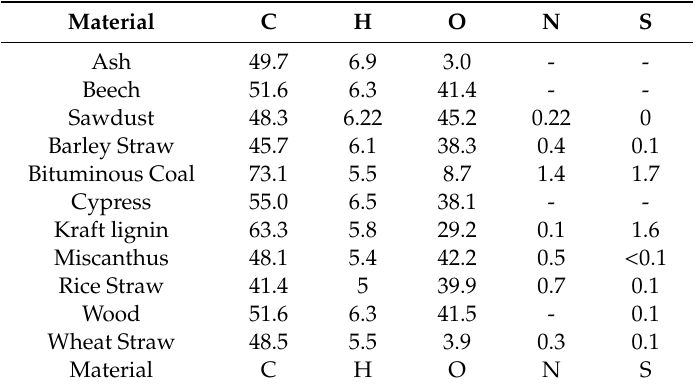
Table 2. Typical elemental analysis for different biomass materials (wt.%) [11,25,26].